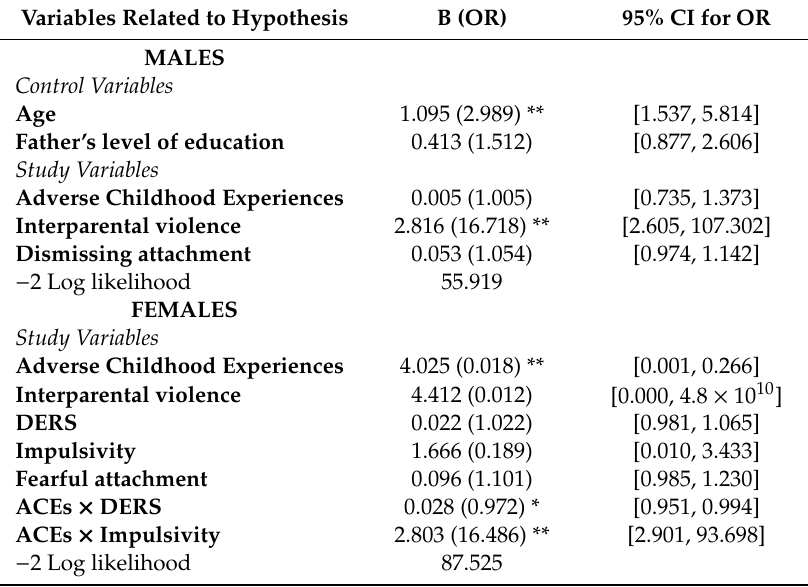
Table 6. Logistic regression: Relationship between study variables and physical TDV perpetration using all four items of the CADRI physical abuse subscale in males and females